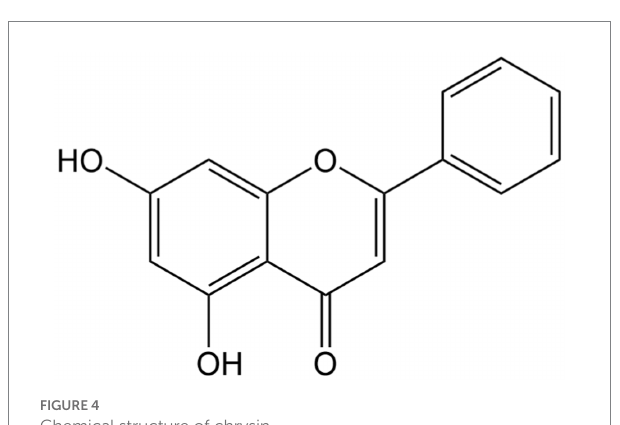
FIGURE 4 Chemical structure of